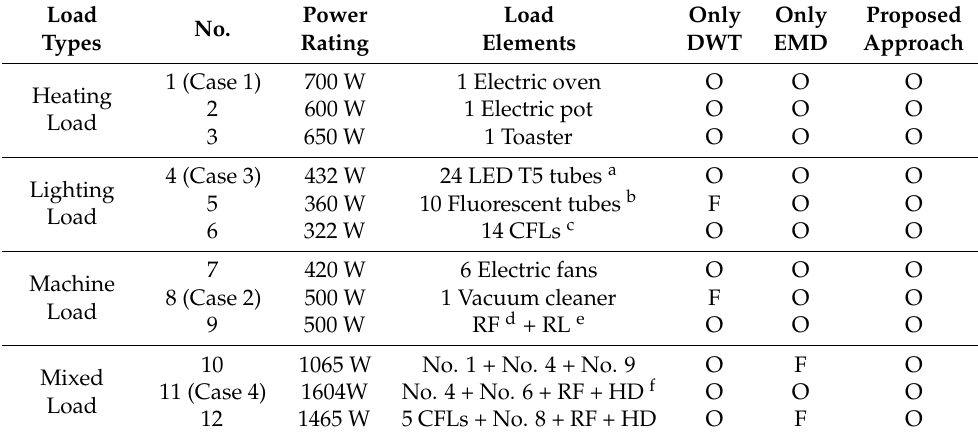
Table 2. Detection results from more various load categories.